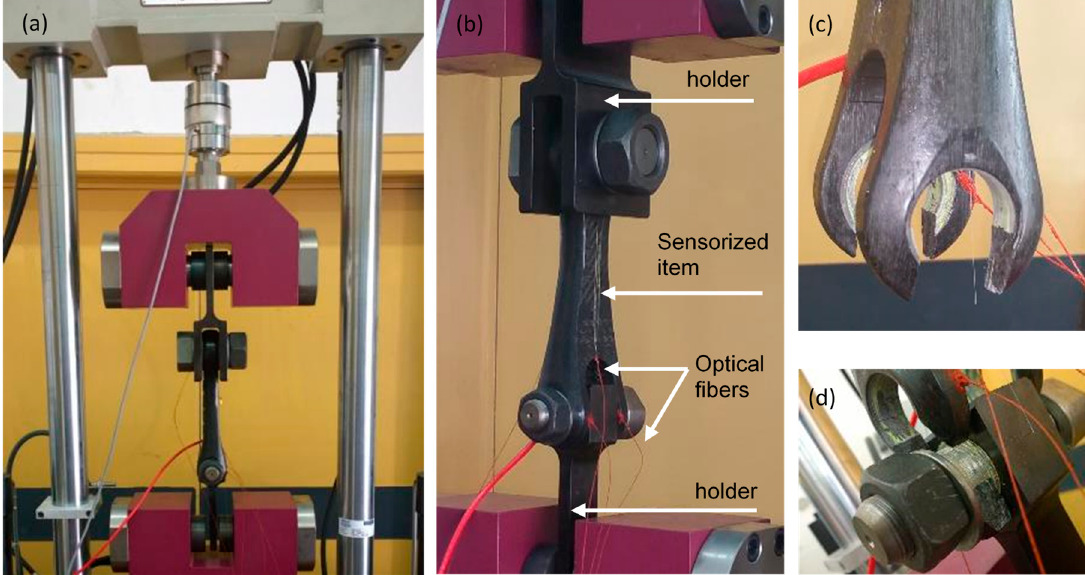
Figure 7. ( a ) and ( b ) Sensorized item fixed in the loading press; ( c ) and ( d ) view of the broken region.